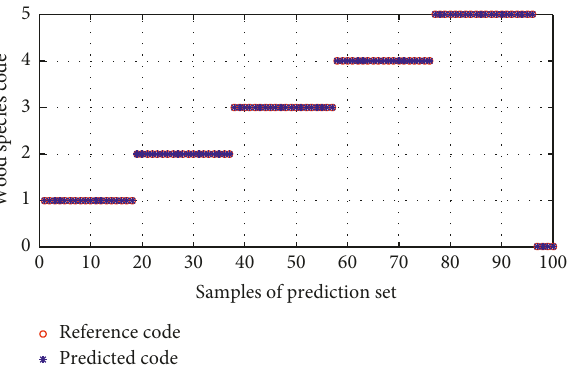
Figure 7: Classification result of the BP neural